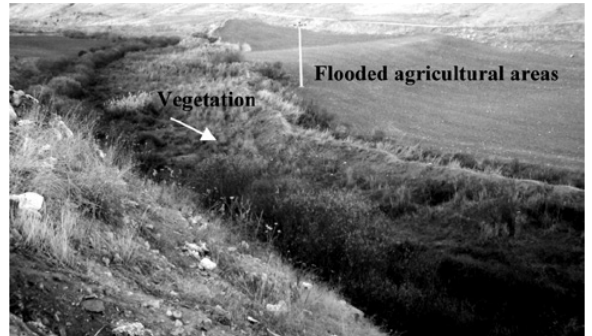
Fig. 6. Goksu channel banks covered by dense vegetation